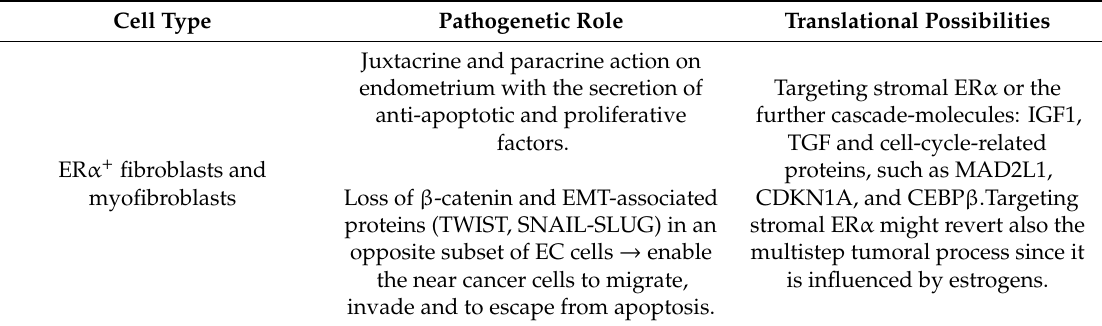
Table 2. Main cell types of the EC’s TEM, their principal role in endometrial cancer (EC) pathogenesis and the possible translational